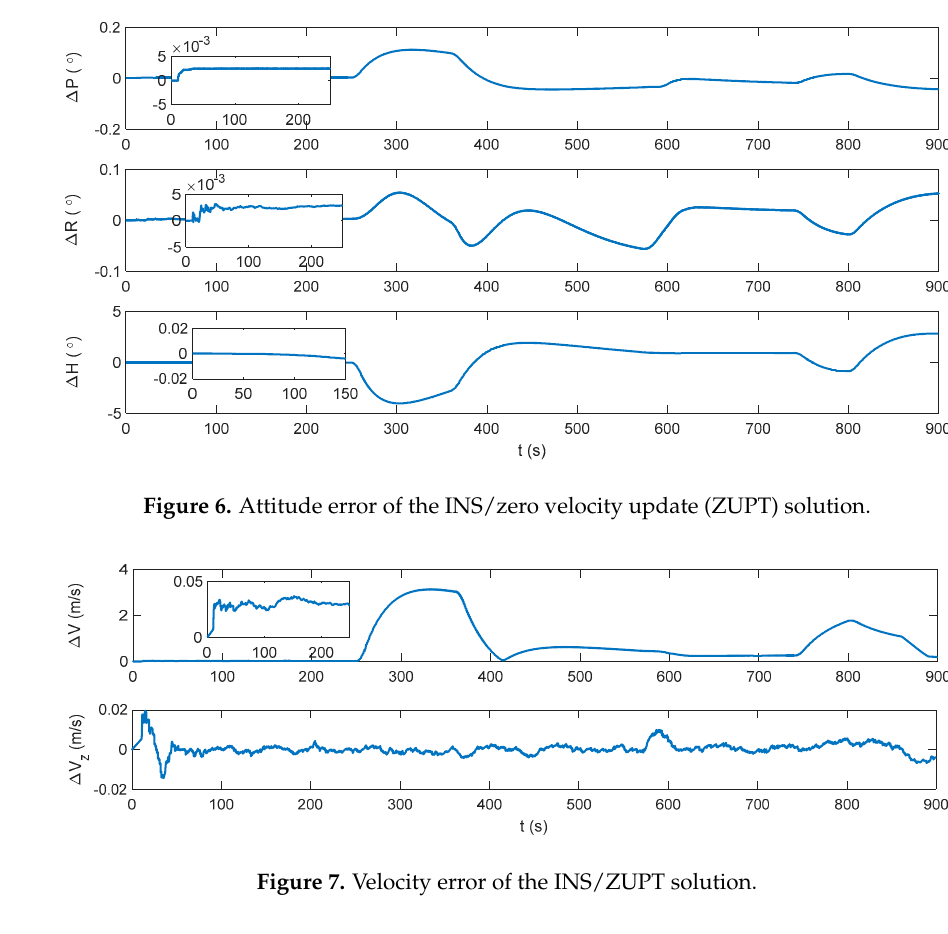
9 of 16 Figure 4. Velocity error of the INS/DVL-integrated navigation system. Figure 5. Position error of the INS/DVL-integrated navigation system. It can be seen that the attitude error is below 0.005 ° , 0.005 ° and 0.05 ° in pitch, roll, and yaw, respectively. Due to the erroneous velocity information provided by DVL, the mean value of the horizontal velocity error is 0.04149 m/s. The vertical velocity is only about 0.01 m/s because a depthometer is involved in the system to restrict the vertical errors. The horizontal position error increases monotonically with time, reaching 31.22 m at 900 s, and the vertical positioning error is within 0.2 m. In an INS/DVL underwater navigation system, where the external velocity data forms